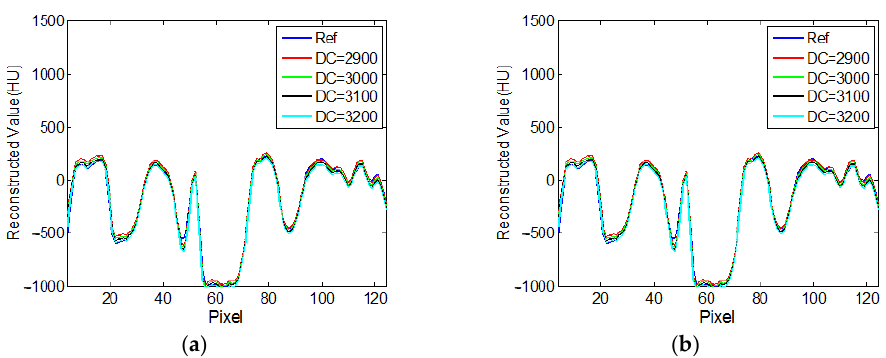
Figure 11. Profiles along different reconstruction results in Figure 10: ( a ) horizontal central line; ( b ) vertical central line.